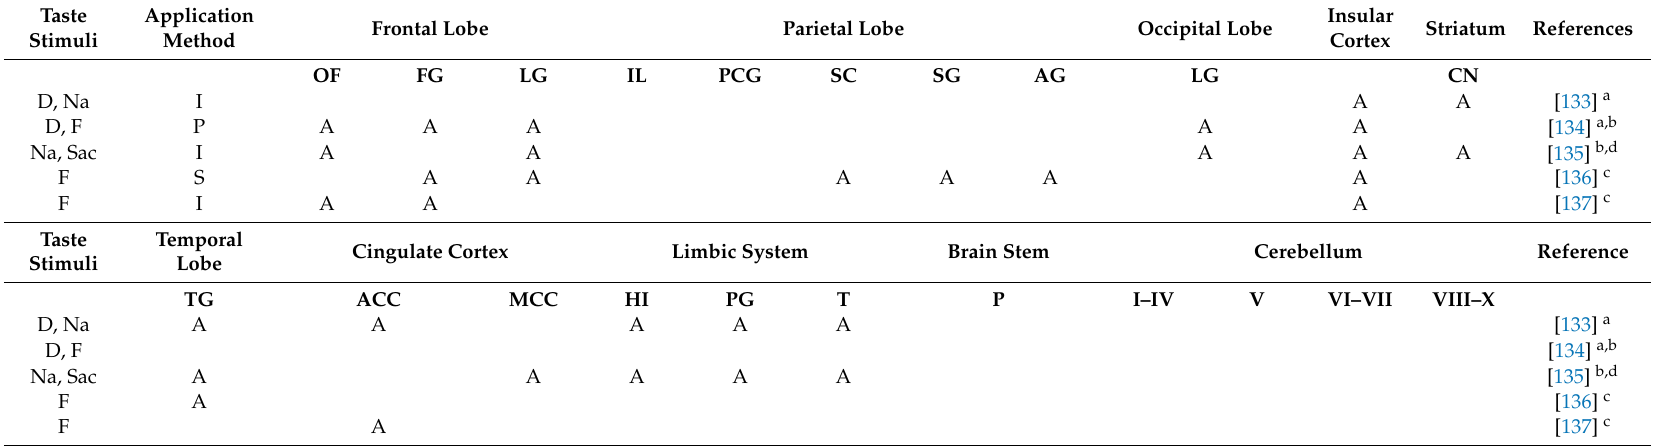
Table 5. Activation (A) of human brain regions and loci in response to taste